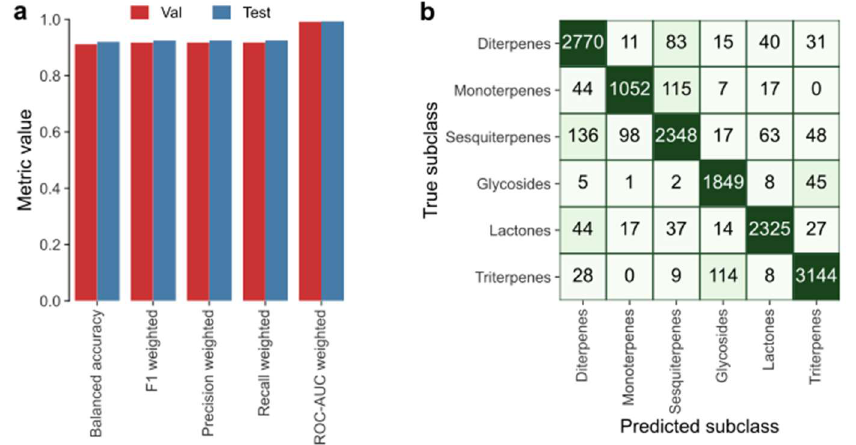
Figure 8. LightGBM applied on the terpenes data, by the parameters described in Supplementary Table S7. ( a ) Cross-validation and test results and ( b ) confusion matrix for the test data.